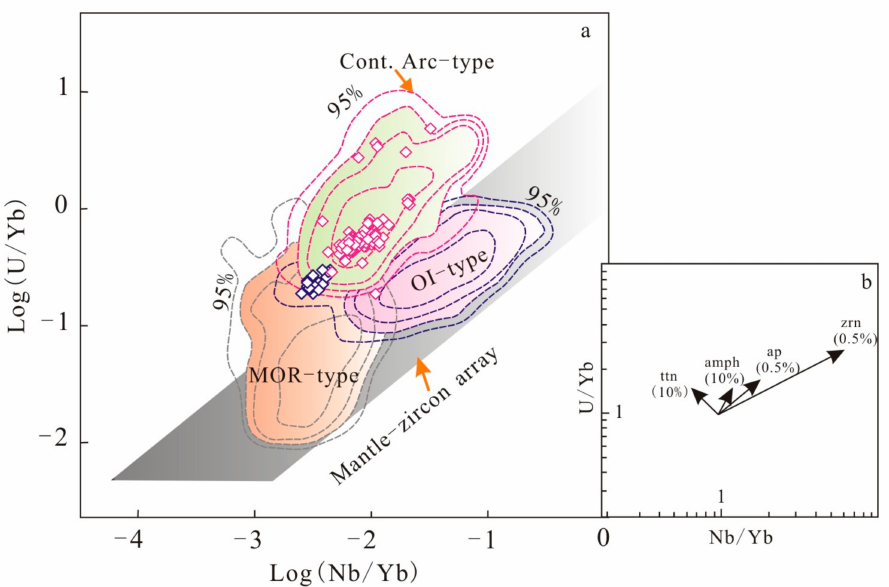
Figure 8. ( a ) Density distribution plots of zircon log (U/Yb) versus log (Nb/Yb) for discrimination of tectono-magmatic setting of the DBS-TS porphyry Cu-Mo deposit. Note: (1) The three shaded fields (green, pink and orange) are two-dimensional kernel density distributions for compiled datasets of mid-ocean ridge (MOR-type), plume-influenced settings of Iceland and Hawaii (ocean-island (OI)-type), and continental arc (Cont. arc-type) zircon by Grimes et al. [82]. The contours shown are for 50%, 80%, 90%, and 95% levels, which represent the proportion of points inside the contour (after [82]). (2) All the zircons in the study area plot above the “Mantle- zircon array” and close to the upper bound. (3) Zircons in early Paleozoic DBS-TS deposit plot into the contour of 50% Cont. Arc-type, and the zircons in early Mesozoic Qz-monzonite plot in the overlapping area toward MOR-type. (4) The colored symbols are the same as in Figure 7a. The inset ( b ) shows the effect of fractionation of select minerals on U/Yb and Nb/Yb ratios of the remaining melt (and later-formed zircons), relative to initial ratios = 1. Vectors are shown to scale for the extent of fractional removal (of that mineral only) indicated by the percentages listed (after [82]). Ttn = titanite, amph = amphibole, ap = apatite, and zrn =